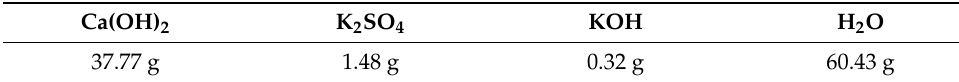
Table 2. Composition of 100 g of alkaline R 3